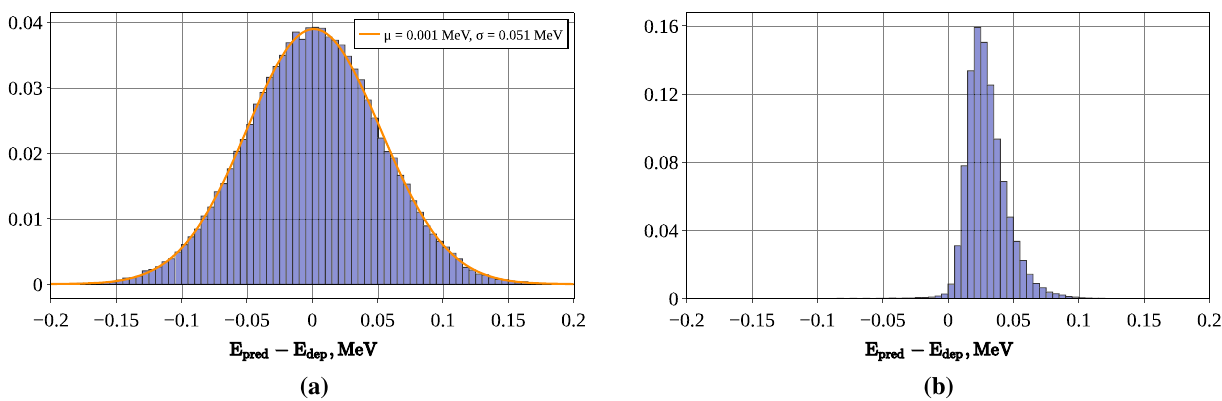
Fig. 13 Examples of distributions of the predicted deposited energy for E dep = 3 . 022 MeV ( a ) and E dep = 1 . 022 MeV ( b ). The orange line in the left figure represents the Gaussian fit. The distributions were obtained using the BDT model